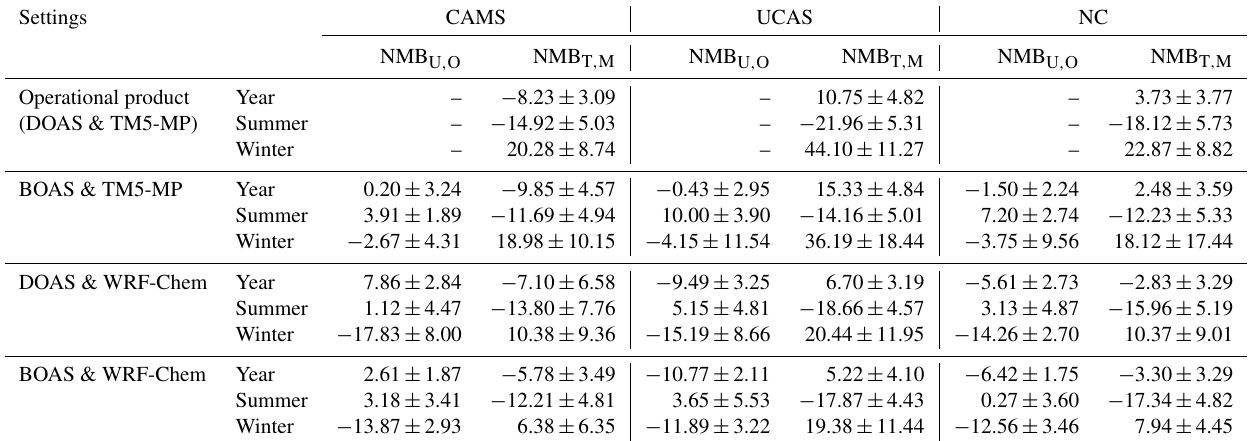
Table 5. Normalized mean biases (NMBs) between the updated and operational TROPOMI HCHO VCDs (NMB U , O ) and NMBs between TROPOMI and MAX-DOAS observations (NMB T , M ). TROPOMI HCHO VCDs are updated with three different settings: (1) replacing DOAS SCDs using BOAS SCDs in the operational product, (2) changing the a priori profiles from TM5-MP to regional WRF-Chem simula- tions in the operational product and (3) changing both (1) and (2) in the operational product. The error bars ( ± Error NMB ) are also presented. The NMBs and theirs errors are calculated following Eqs. (17) and (18), respectively. All values are in %.